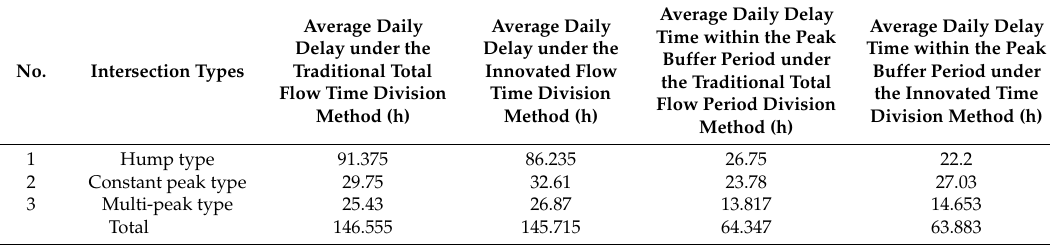
Table 4. Adaptability analysis table of the four types of intersections by the innovated time period